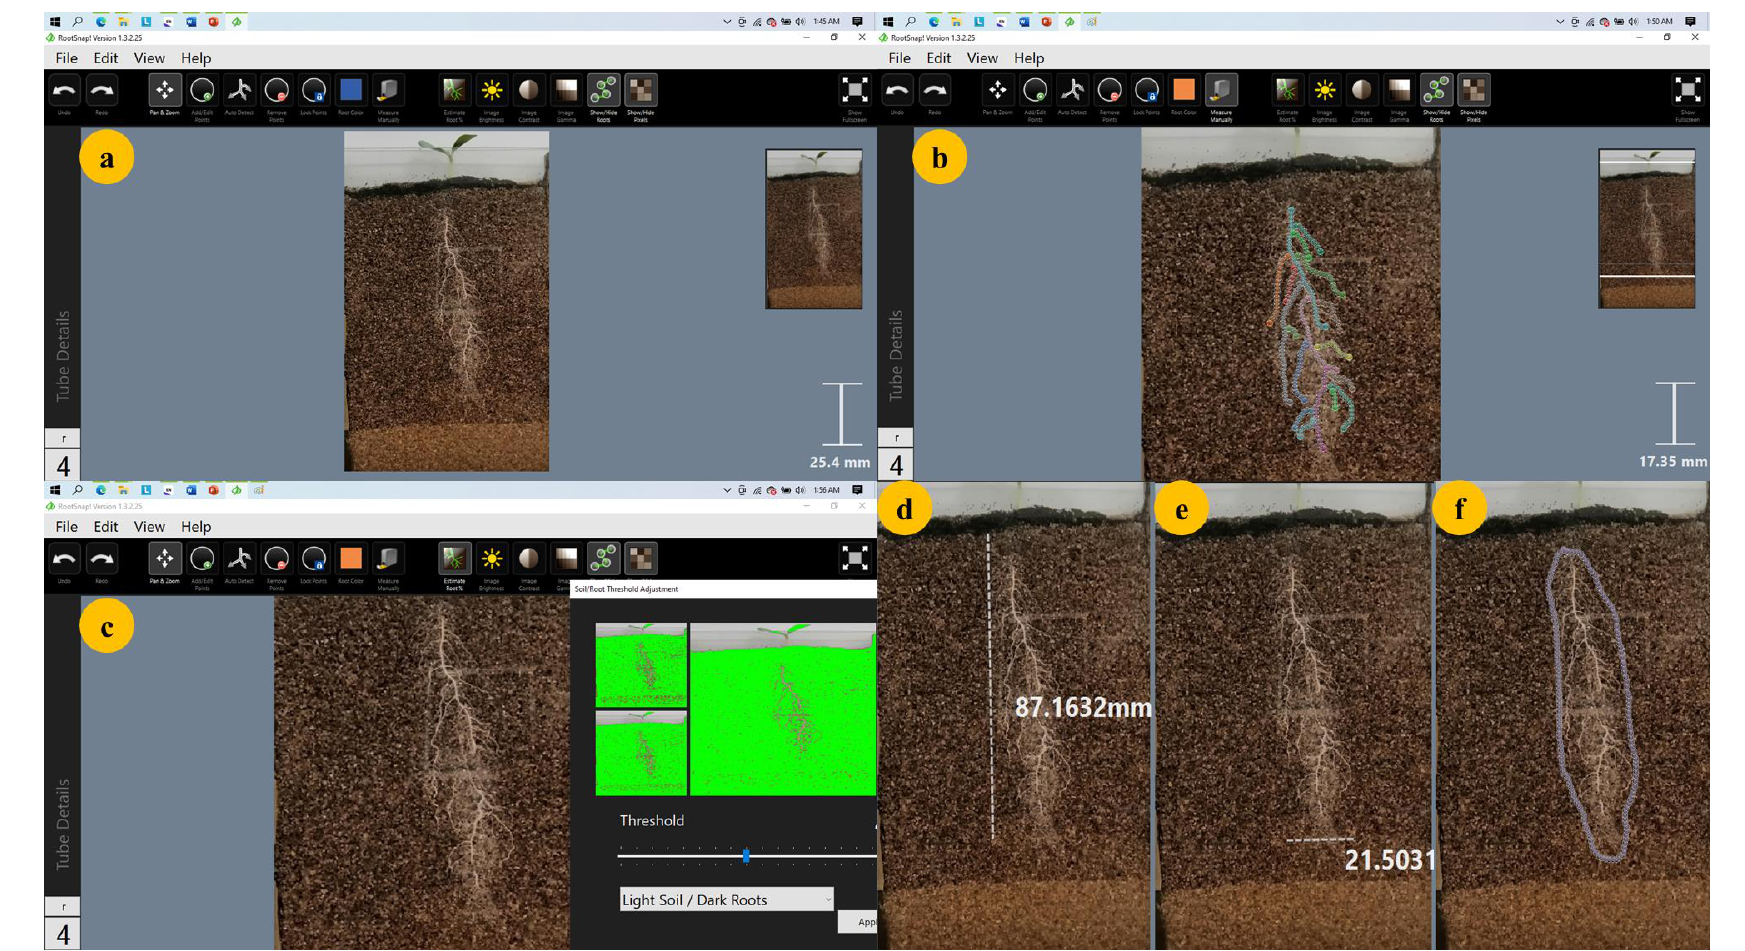
Figure 8. Illustration of how RootSnap software was used to analyse and collect data from captured root images: ( a ) root image in raw format imported from local storage to RootSnap; ( b ) tracing the root using Microsoft Surface Pro 4 stylus to measure total root length; ( c ) automated digital image analysis mode; ( d ) measurement of root system depth; ( e ) measurement of root system width; ( f ) measurement of root convex hull area.